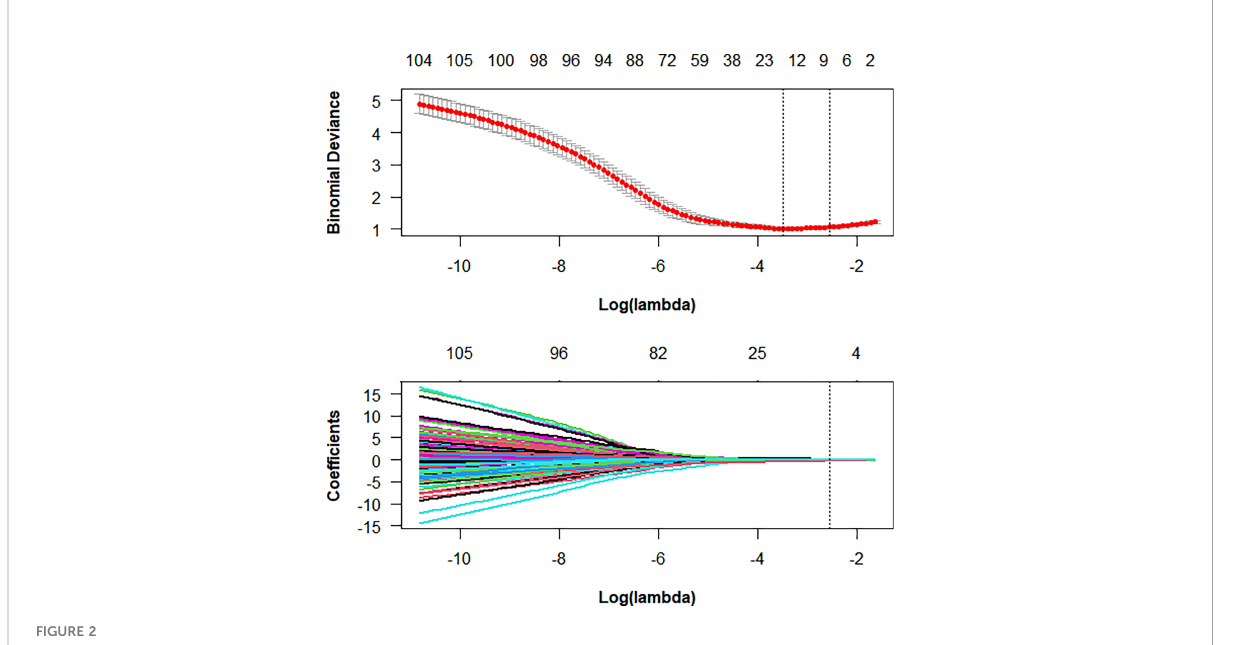
FIGURE 2 Radiomics feature selection using LASSO logistic regression in the training